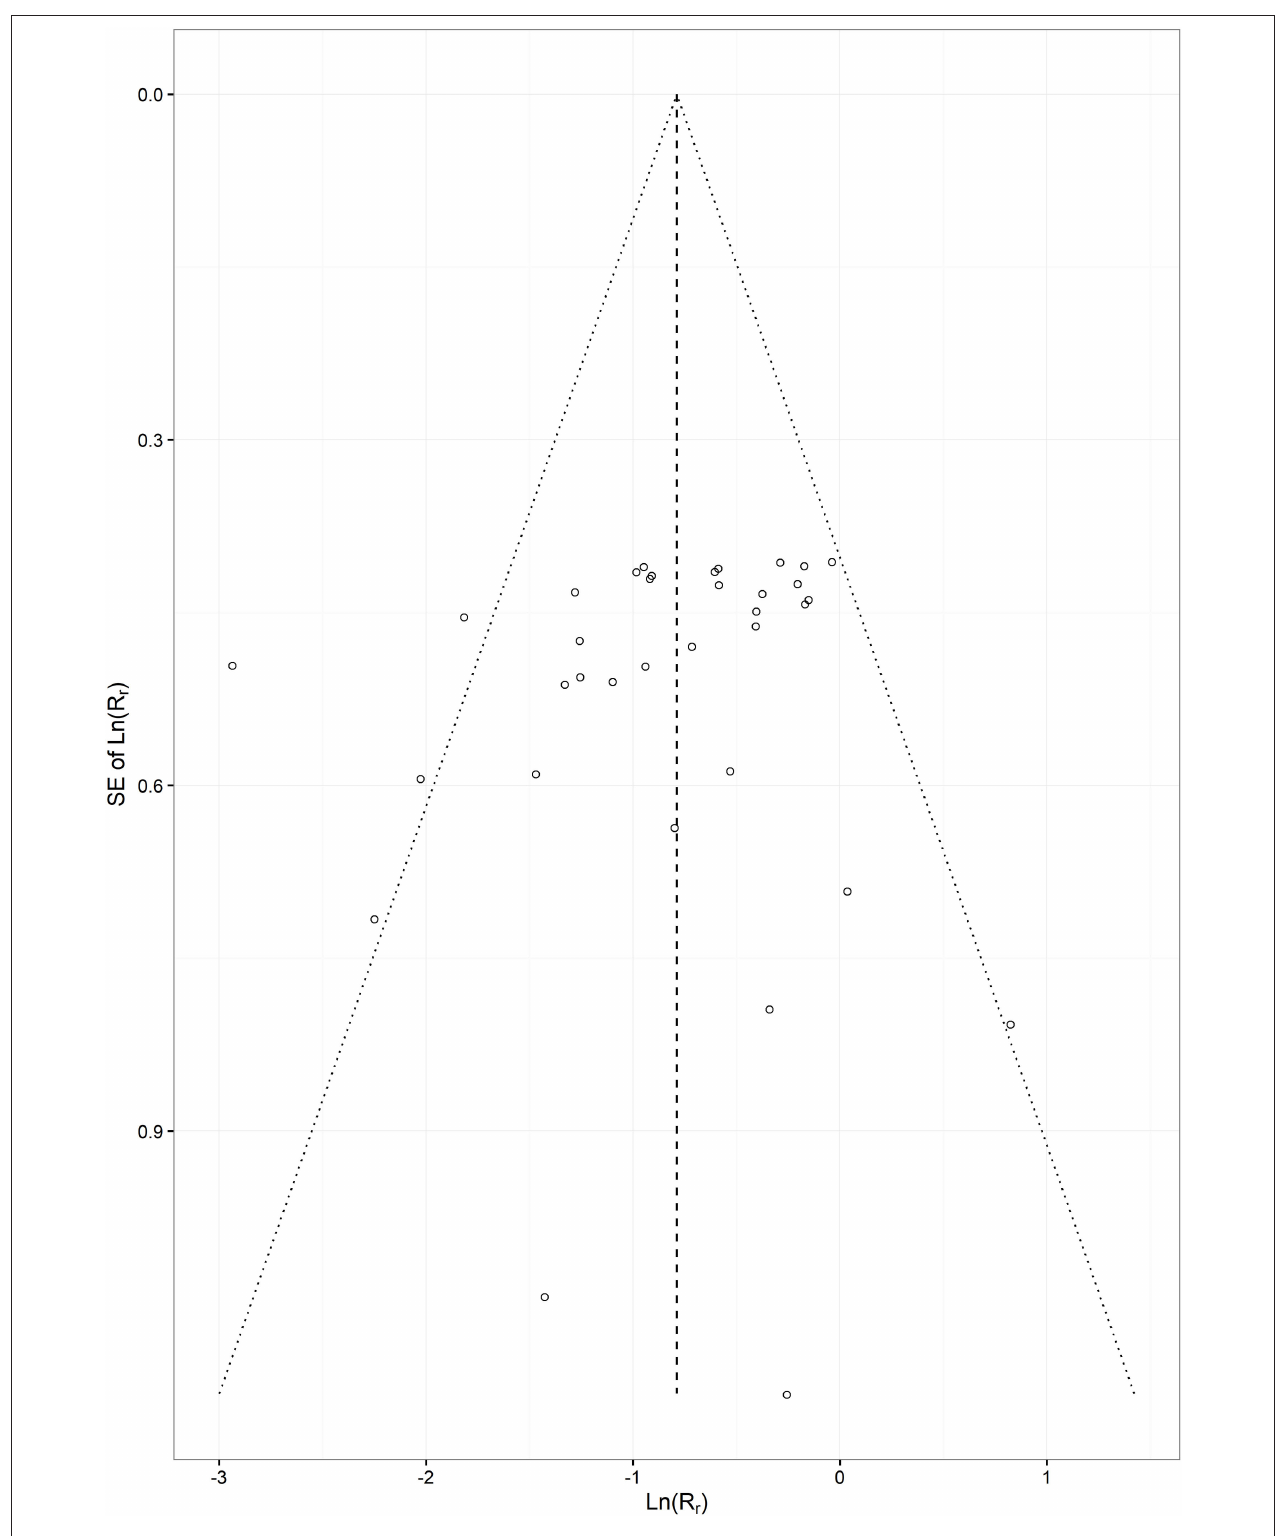
FIGURE 2 | Funnel plot with the 95% confidence interval region.